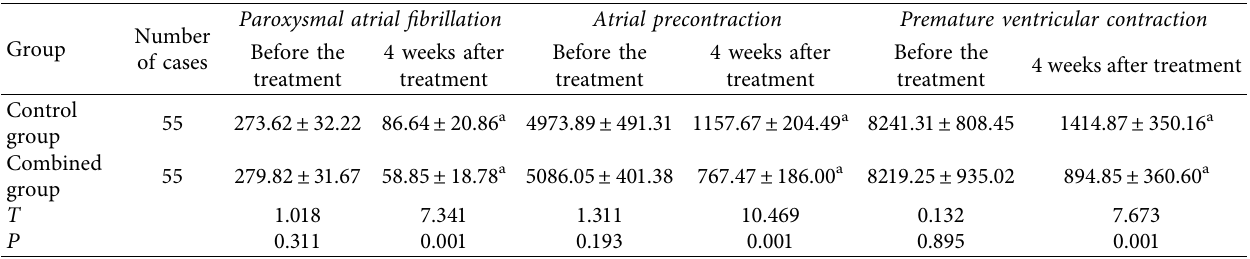
Table 2: Comparison of arrhythmia between the two groups ( n , x ± s , times).